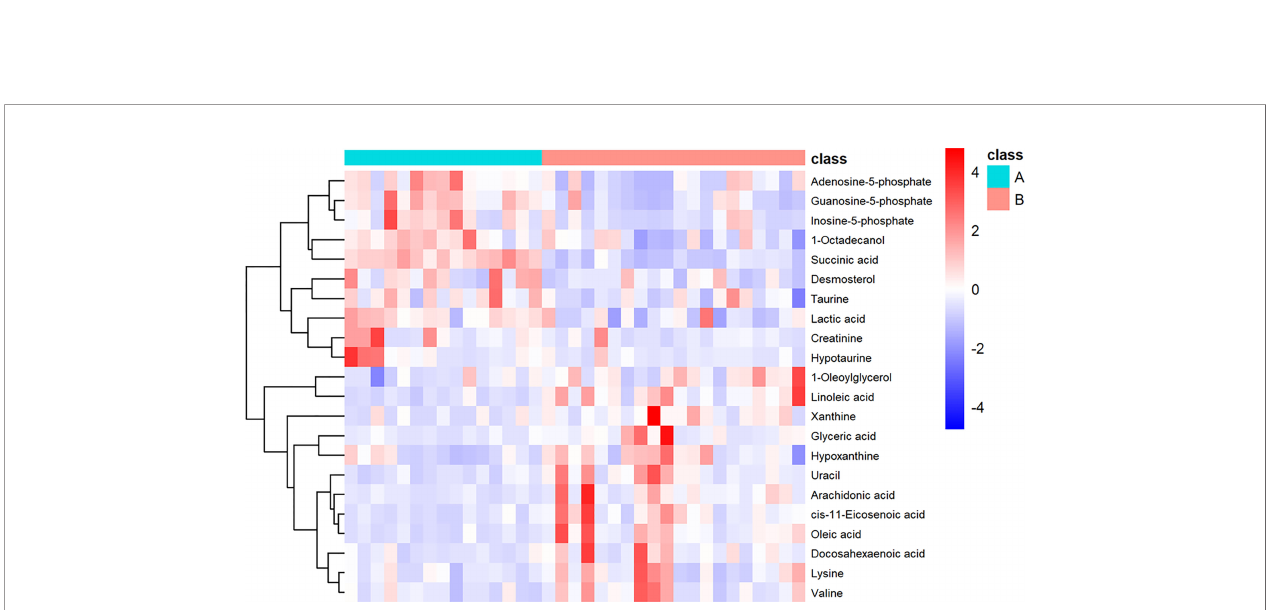
FIGURE 3 | Heatmap showing the 22 important metabolites for invasive nonfunctioning pituitary adenoma (NFPA) and non-invasive NFPA tissues. Class A (invasive NFPA), Class B (non-invasive NFPA).